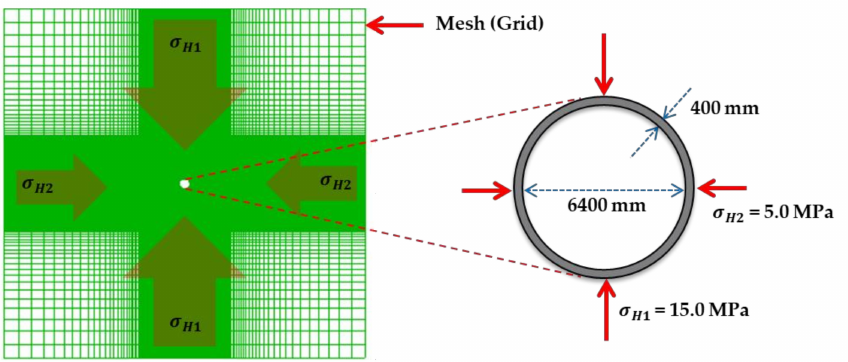
Figure 8. Numerical analysis model of the shaft.